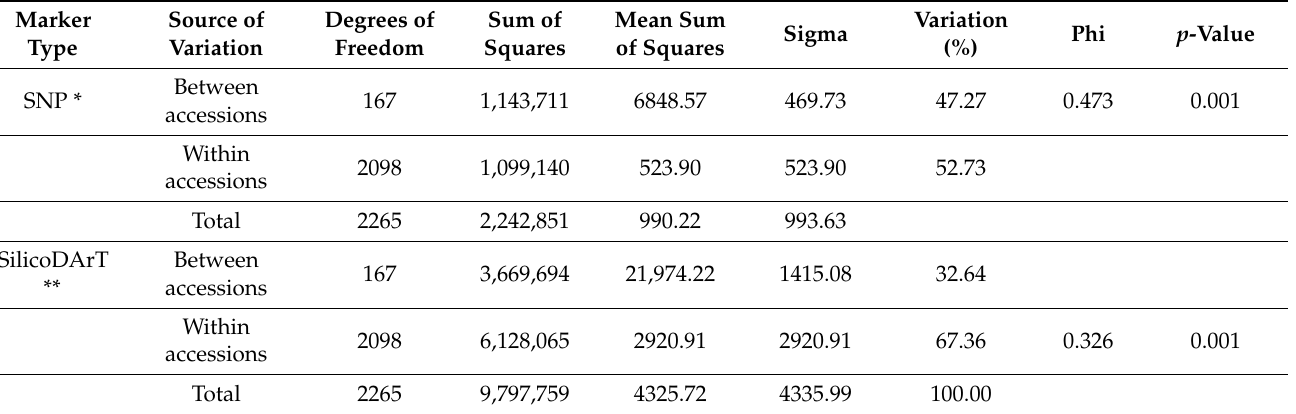
Table 2. AMOVA result showing the contribution of ‘between’ and ‘within’ accessions diversity to the total diversity in the